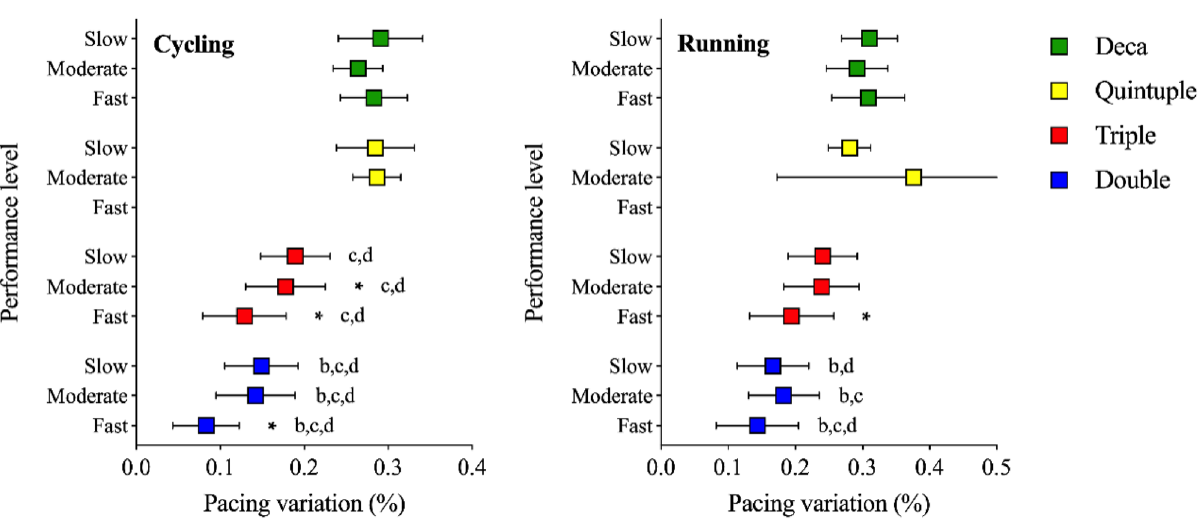
Figure 3. Cycling and running pacing variation in Double, Triple, Quintuple, and Deca Iron ultra-triathlon by different performance levels. *: different from all other performance levels within the same race, b: different from Triple within the same performance level, c: different from Quintuple within the same performance level, d: different from Deca within the same performance